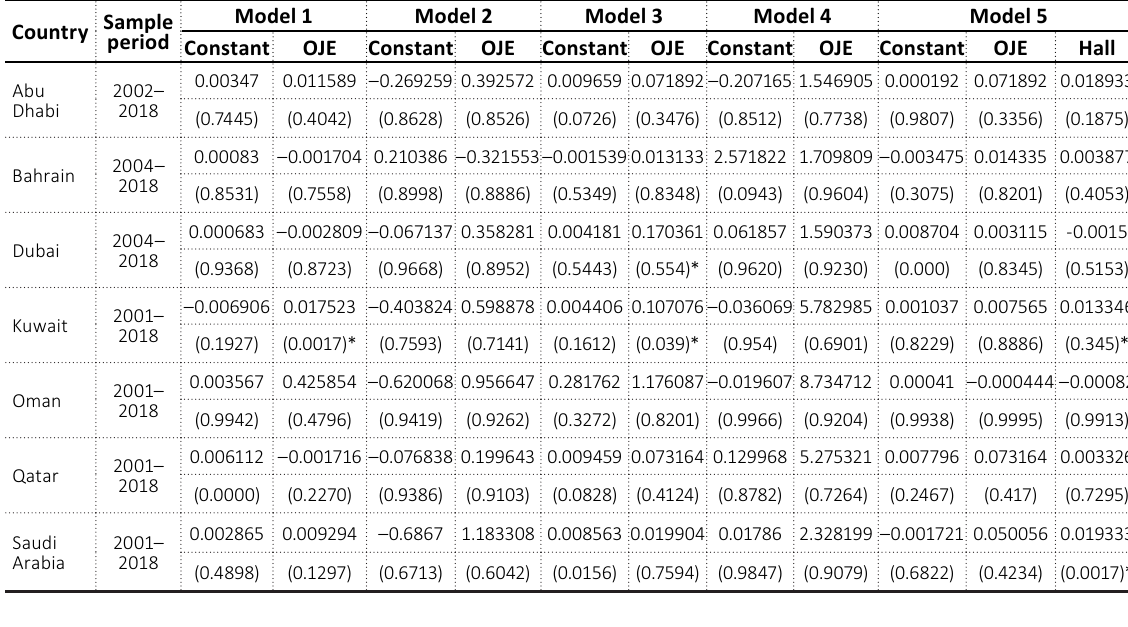
Table 4. Estimated